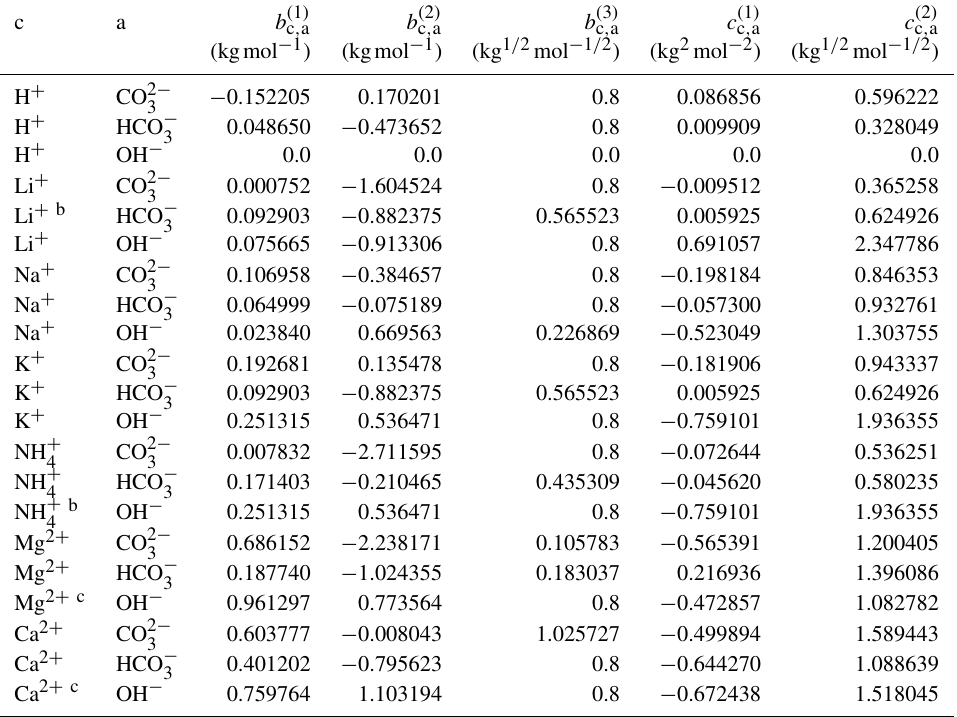
Table 10. Determined middle-range interaction parameters between cation–anion pairs in aqueous carbonate electrolytes a